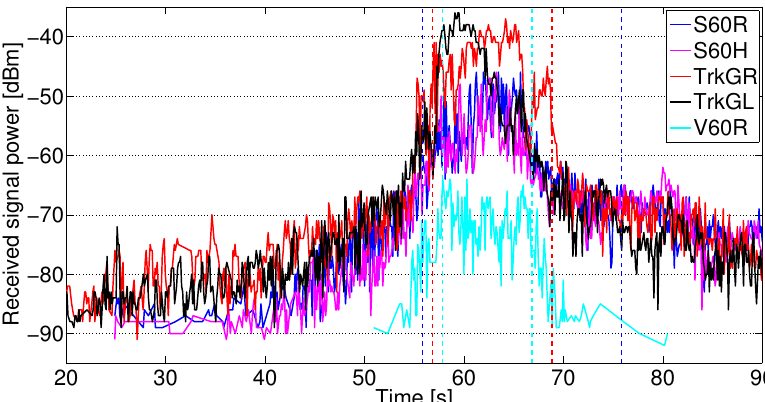
Figure 5. Received signal power at the XC90 Silver Roof antenna from all vehicles in group 2 during one of the measurement iterations. The dotted lines indicate when the XC90 Silver Roof antenna has line-of-sight (LOS) communication with S60 (blue) and Truck Gold (red). The cyan dotted lines indicate OLOS communication between the XC90 Silver Roof antenna and the V60 Roof